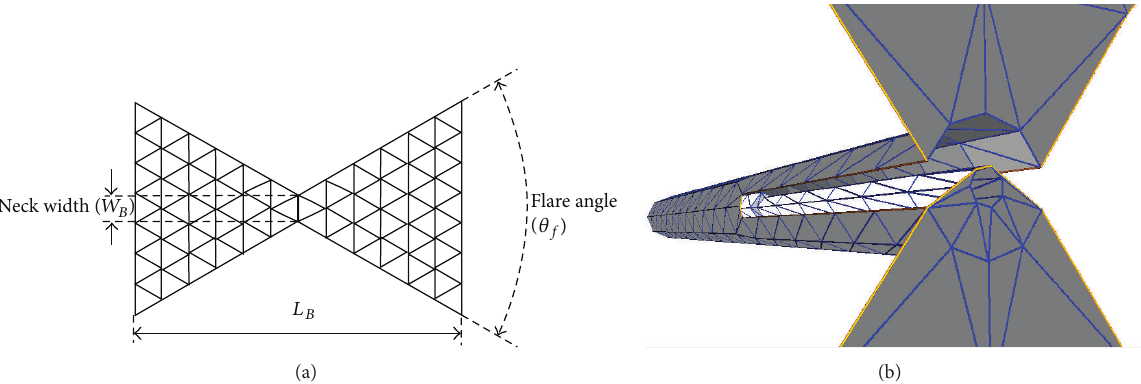
Figure 16: Geometric model of (a) bowtie antenna with the dimensional parameters and (b) bowtie antenna fed through a split coaxial balun (zoom-in view at the feeding location).